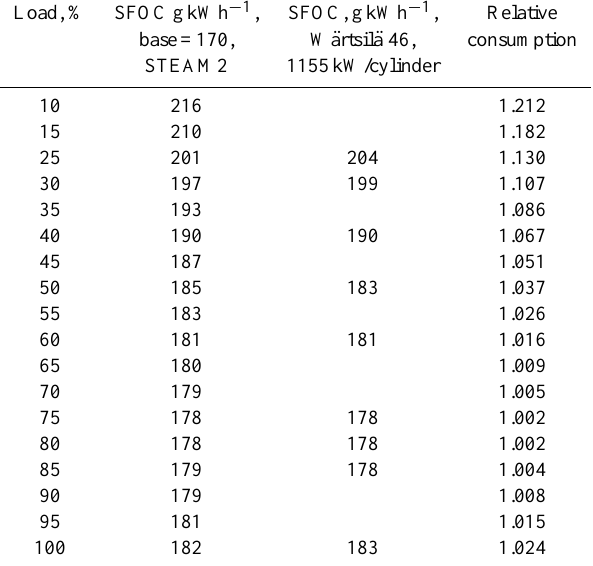
Table B3. Specific fuel-oil consumption measurements as a func- tion of engine load, extracted from CAT engine documentations for four-stroke engines. Relative SFOC-values have been computed us- ing the specified SFOC value for each